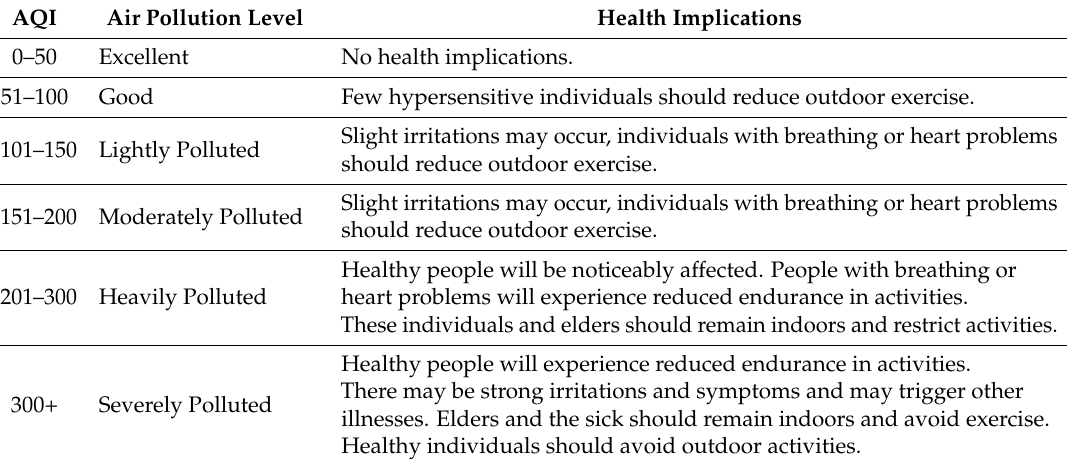
Table A1. AQI category and health implications according to ambient air quality index (AQI) technical regulations (trial) (HJ